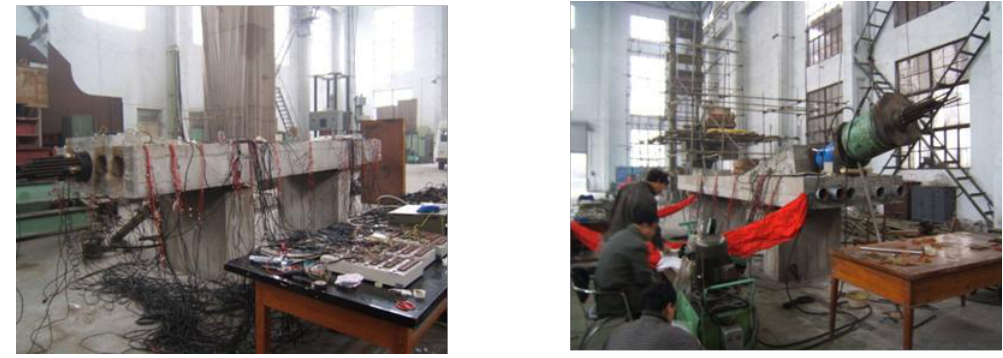
Figure 3. Full-scale specimens: ( a ) top slab; and ( b ) bottom slab.